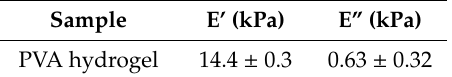
Table 1. Elastic modulus (E’) and loss modulus (E”) for PVA hydrogel (8% wt). Sample